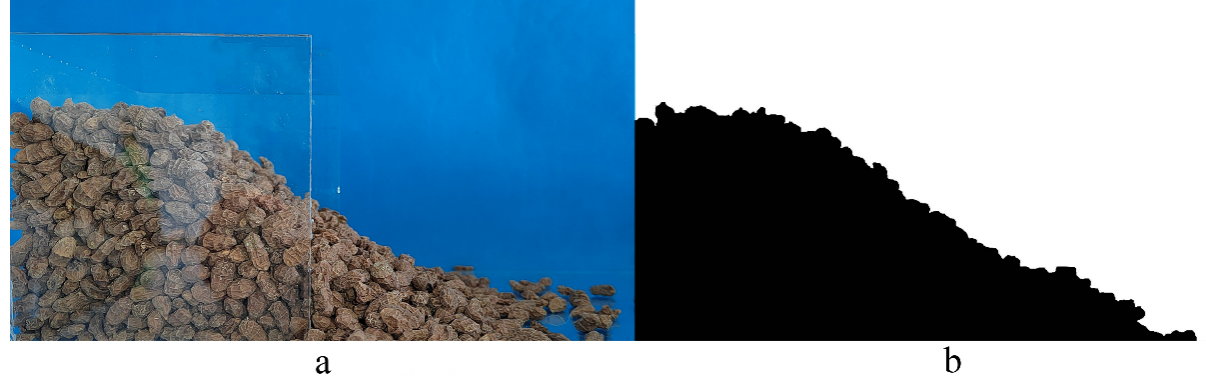
Figure 19. Packing test: ( a ) photograph of the piling test captured by a high-speed camera; ( b ) image binarization.